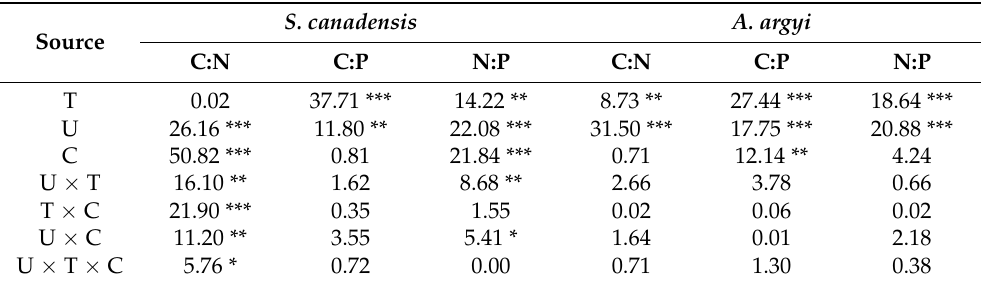
Table 3. Mixed effects analysis of temperature (T), UV light (U), and plant community (C) on plant nutrient ratios of invasive Solidago canadensis and native Artemisia argyi when grown in monoculture and together in a mixed